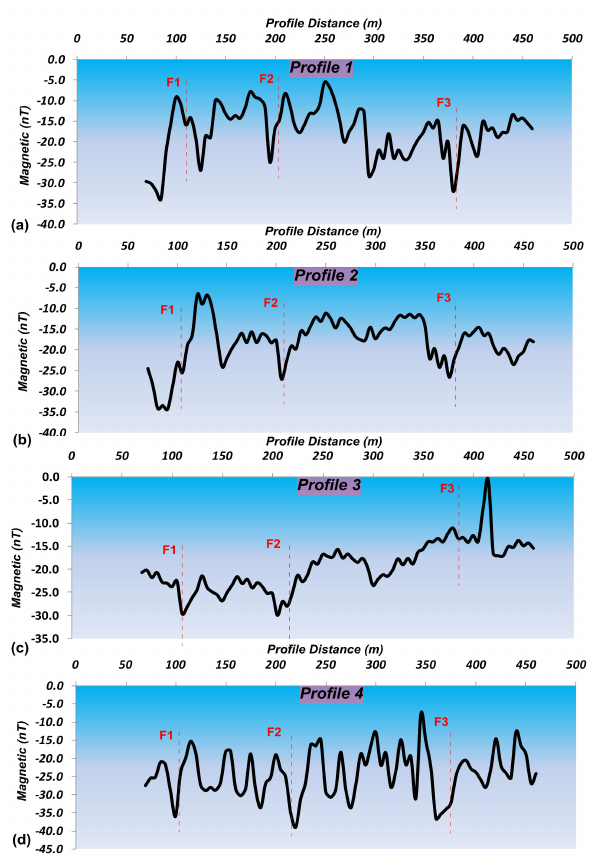
Figure 14. Graphical plots of magnetic data along ( a ) profile 1, ( b ) profile 2, ( c ) profile 3 and ( d ) profile